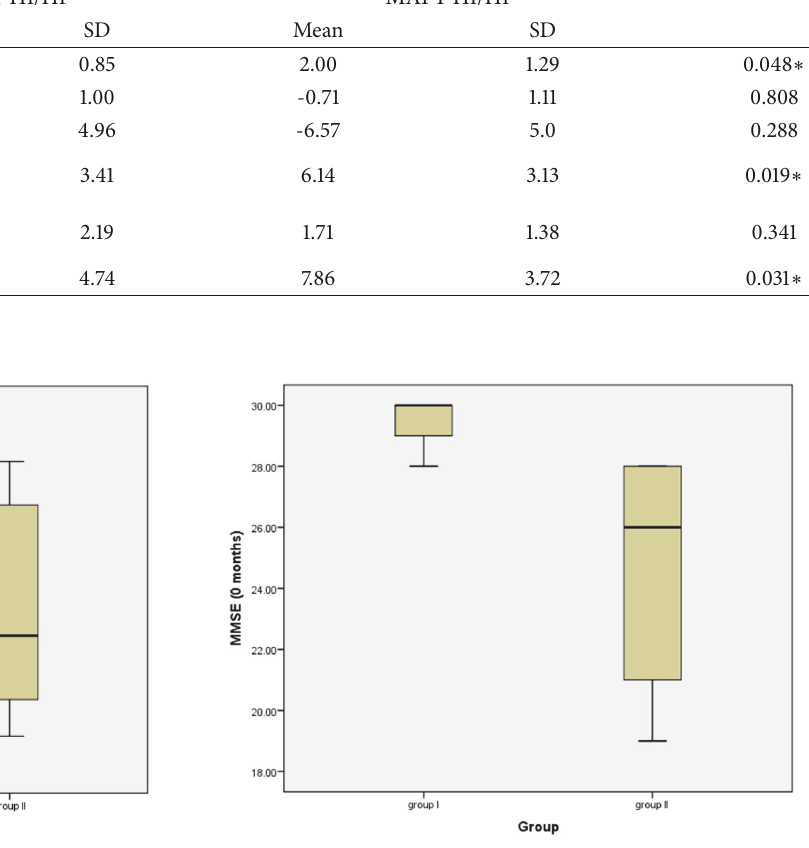
Figure8:MeanscoreofMMSEforMAPTH1/H1haplotypepatients between Group I and Group